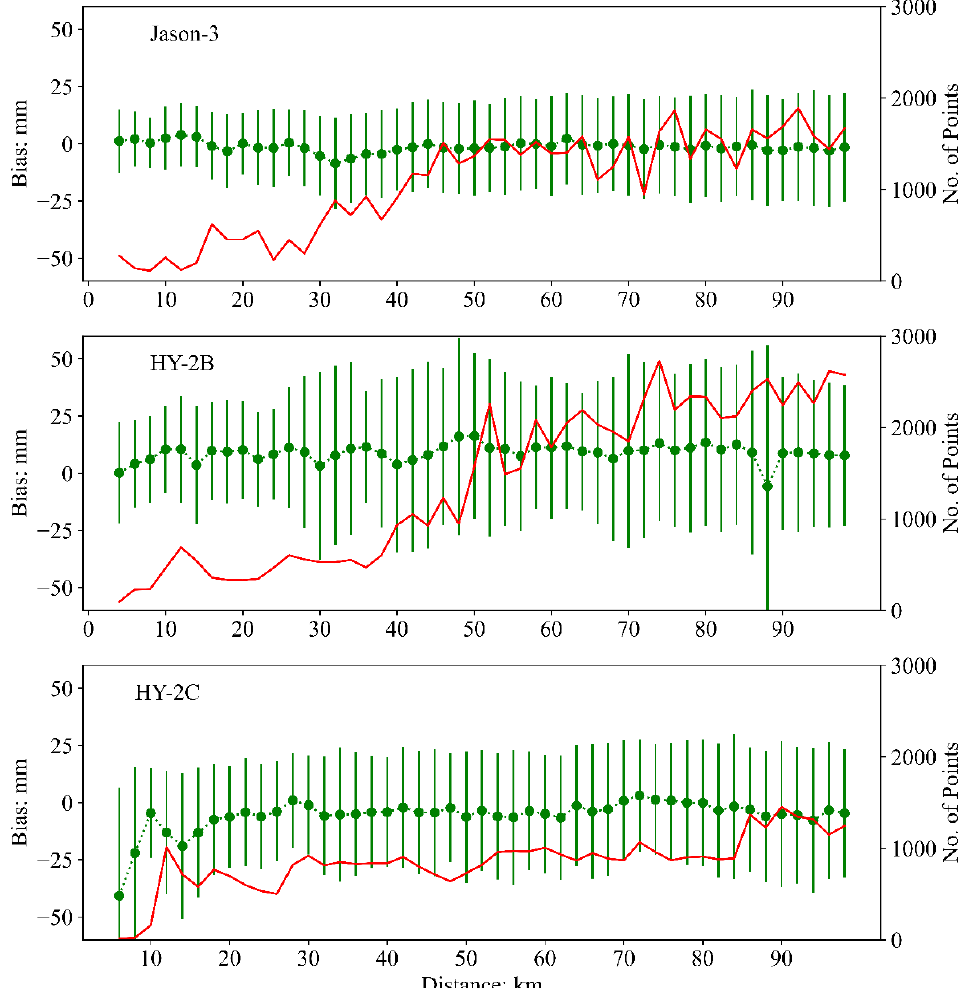
Figure 11. Comparison of ZWD derived from PGSs and MWR (MWR—PGSs). The x-axis is the distance between the PGSs and altimeter footprints. The green dots and lines represent the bias and RMS, respectively. The red line represents the matching data number. The HY-2C had no ZWD data when the distance was less than 4 km to the coast.